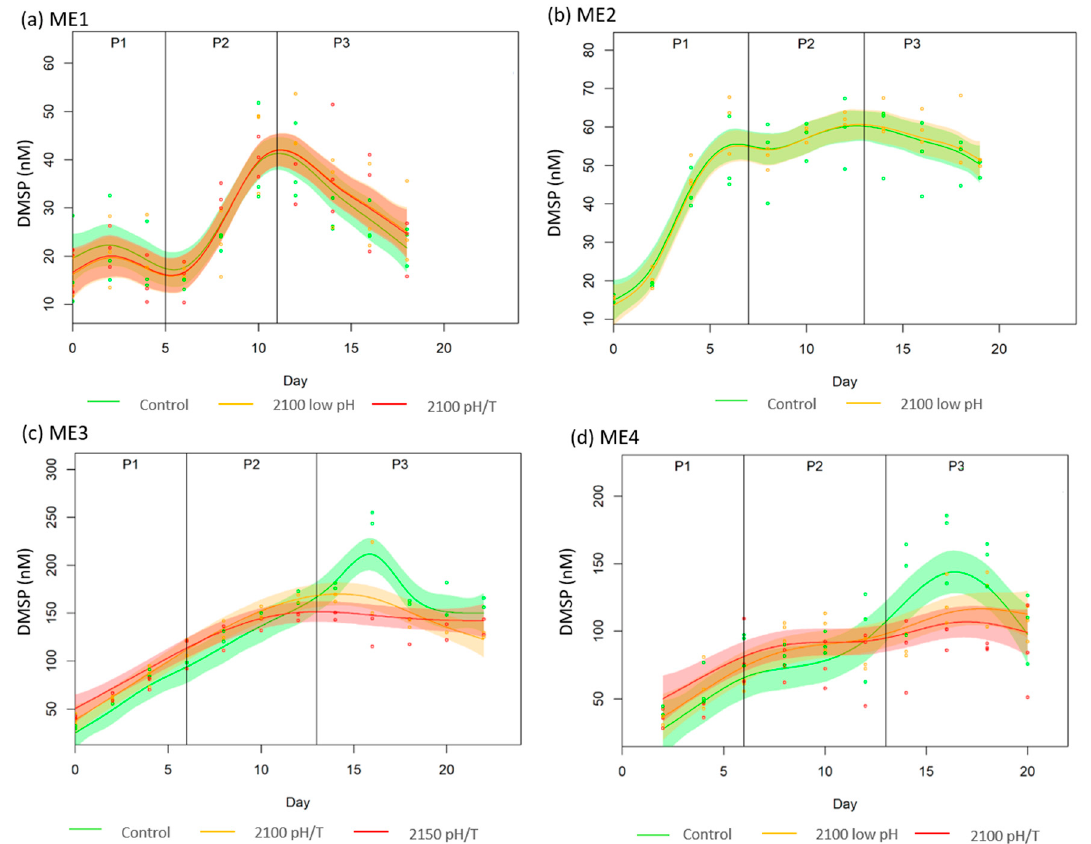
Figure 2. GAMMs plot of DMSP concentrations (in nmol L − 1 ) during ( a ) ME1, ( b ) ME2, ( c ) ME3, and ( d ) ME4, in each treatment against time. The bold line represents the average for each treatment or control of the data points and the shaded area represents 2 standard errors. Note differences in vertical scales. Table 4. DMSP concentration AICs from models (G), (S) and (GS) for the 4 mesocosms. The model providing the best fit is the one with the lowest AIC (in bold). The (G) model fits a common trajec- tory regardless of treatment, while the (S) and (GS) models incorporate treatment effects.